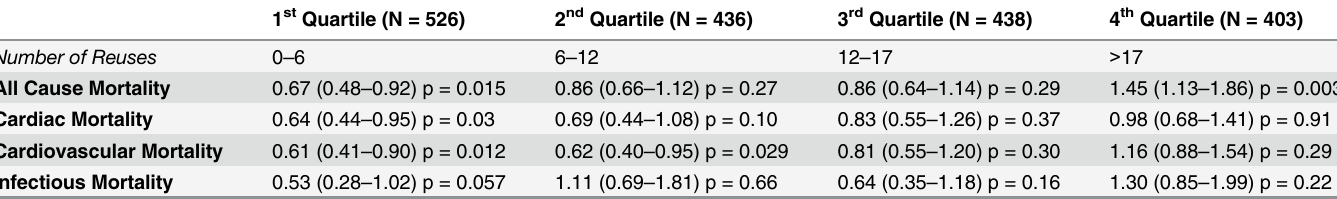
Table 2. Hazard Ratio of Death for All Cause and Cause Specific mortality between High Flux and Low Flux Dialysis versus extent of Reuse. 1 st Quartile (N =